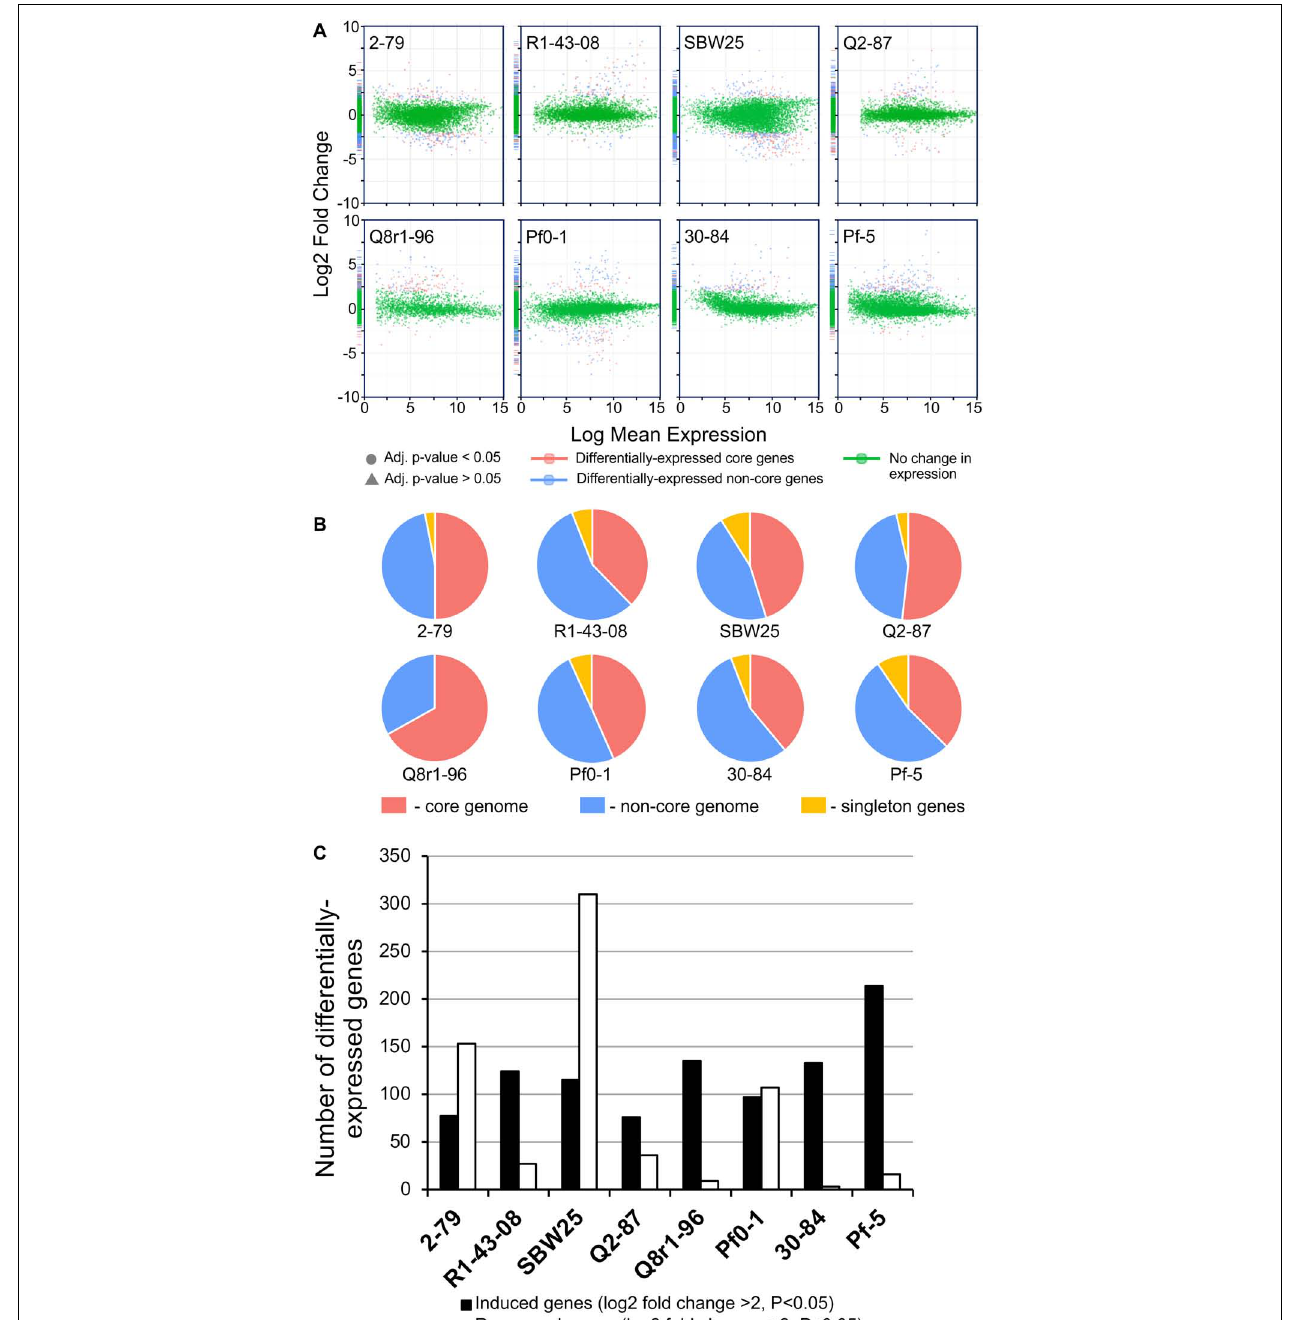
FIGURE 4 | (A) Log ratio versus abundance plots (MA-plots) showing the changes in gene expression in response to root exudates. The differentially expressed core and non-core genes are shown in red and blue, respectively. Green color indicates genes with a log 2 fold-change and/or adjusted p values below the established threshold. (B) Circular diagrams depicting the distribution of differentially expressed genes among the core, non-core, and singleton proteomes of individual Pseudomonas strains. (C) The number of genes per genome that were induced and repressed by B. distachyon root